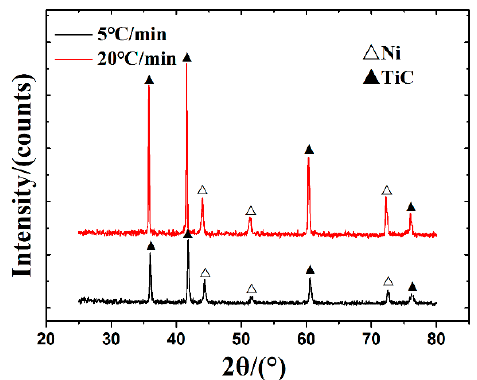
Figure 2. XRD patterns of the sintered green bodies after DTA tests (up to 1200 °C) at heating rates of 5 °C/min and 20 °C/min.